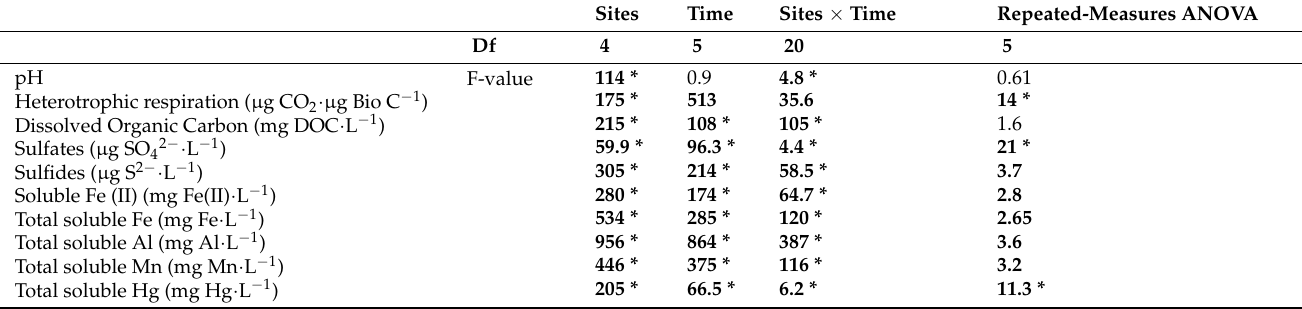
Table 2. Effects of vegetation and incubation period in anaerobic conditions on soil pH, heterotrophic respiration, dissolved organic carbon, sulfates and sulfides content and iron, aluminum, manganese and mercury solubilization for five rehabili- tated mining sites in mesocosm experiment in a two-way ANOVA and repeated-measures ANOVA. Values in bold indicate significant differences at the 0.05% critical level. An * means a highly significant result ( p < 0.001).